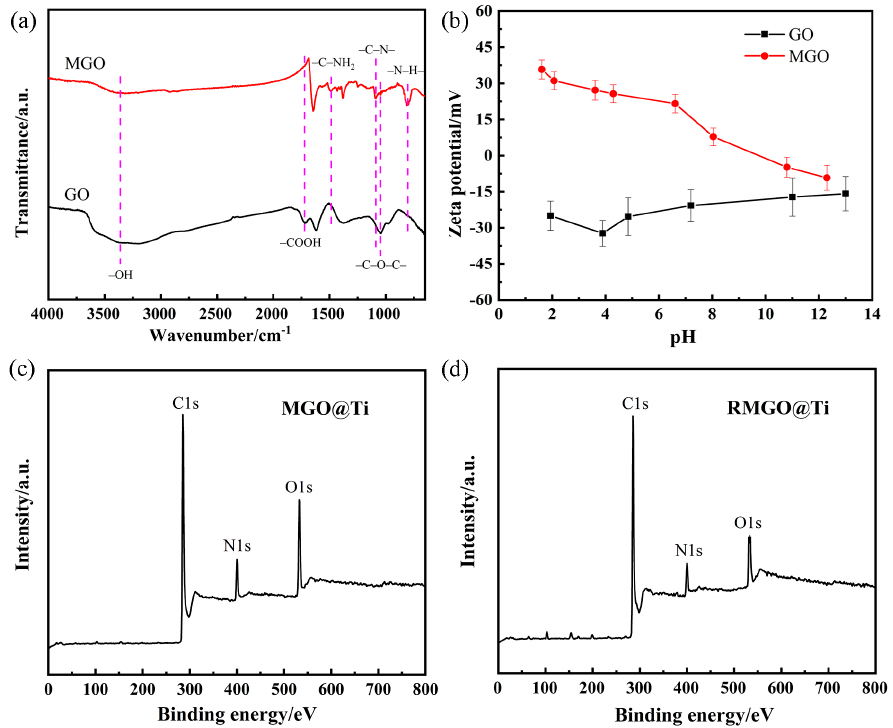
Figure 1. ( a ) FTIR spectra, ( b ) zeta potential of graphene oxide (GO) and modified graphene oxide (MGO) the full XPS spectra of ( c ) MGO@Ti, ( d ) RMGO@Ti.